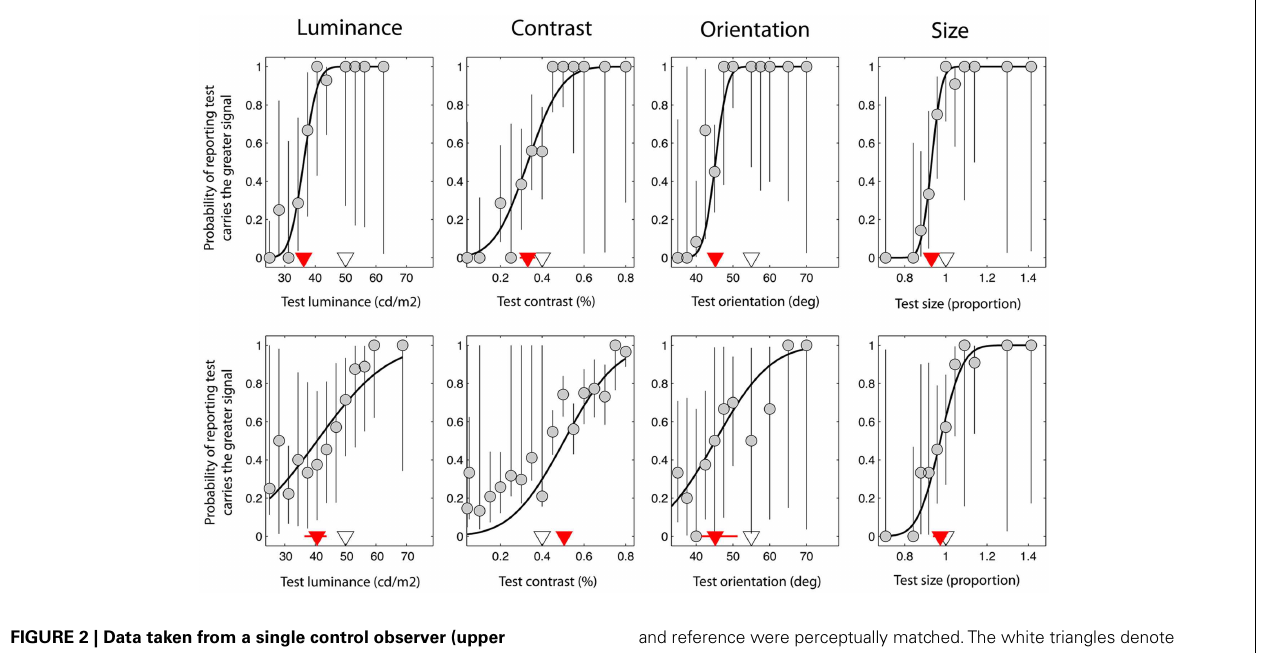
FIGURE 2 | Data taken from a single control observer (upper plots) and a single observer with schizophrenia (lower plots). These were selected on the basis that they were typical of group trends. Red triangles denote the point of subjective equality (PSE) on the abscissa, which represents the test signal level at which the test